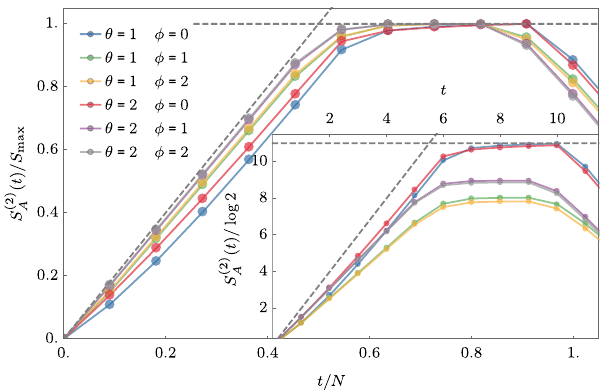
FIG. 8. Time evolution of the second R´enyi entropy for a subsystem of N ¼ 11 spins in a kicked Ising system of L ¼ 30 at the integrable point h ¼ 0 for different translationally invariant initial states. The main panel shows the rescaled curves, which are close to Eq. (94) (black dashed line) given by the quasiparticle picture. In the inset, we show the nonrescaled version, where it is apparent that the saturation value depends on the initial state. Note a recurrence after the time t ¼ 10 , consistent with the quasiparticle